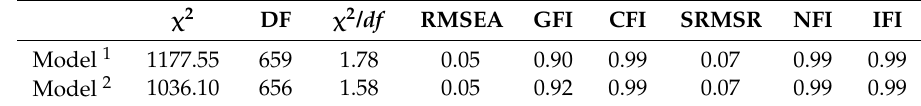
Table 3. Fit indices based on 38 items for measurement model of D-KAP-38.